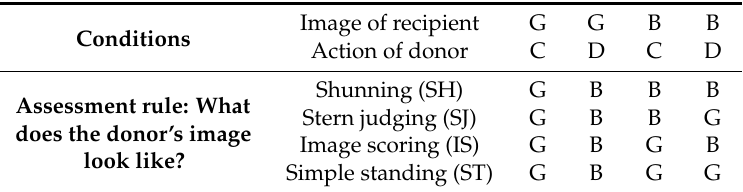
Table 1. What is good and what is bad? “G” and “B”, respectively, describe a good and bad image, and “C” and “D”, respectively, describe offering to help and refusing to help. Image of recipient G G B Conditions Action of donor Shunning Assessment rule: What does the donor’s image look like?